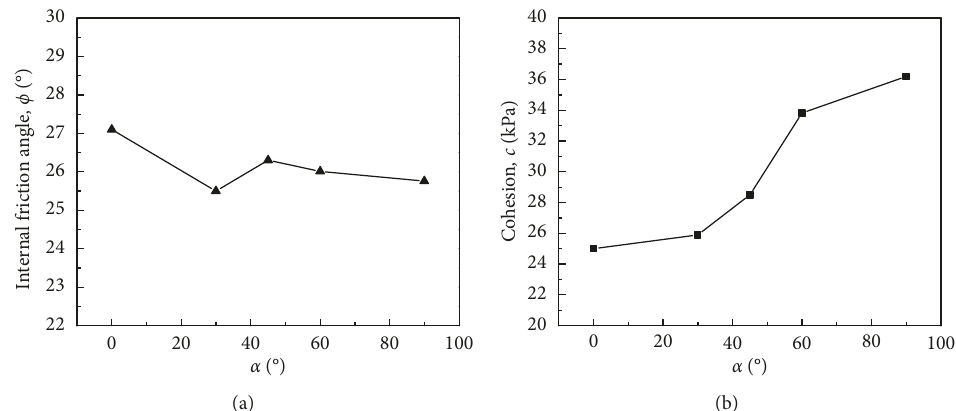
Figure 7: The shear strength parameters obtained from the shear test. The effect of direction on the (a) internal friction angle and (b) cohesion.